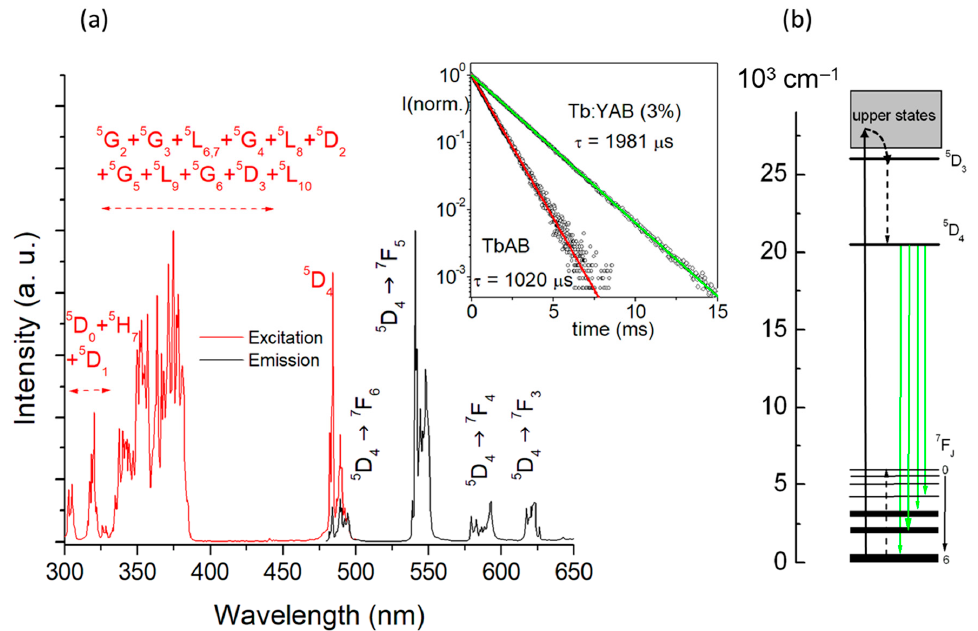
Figure 5. ( a ) Excitation (monitored wavelength: 548 nm) and emission (excitation at 375 nm) spectrum of TbAB. Inset: decay profiles of the Tb:YAB and TbAB emission. ( b ) Energy levels scheme and de-excitation mechanisms.